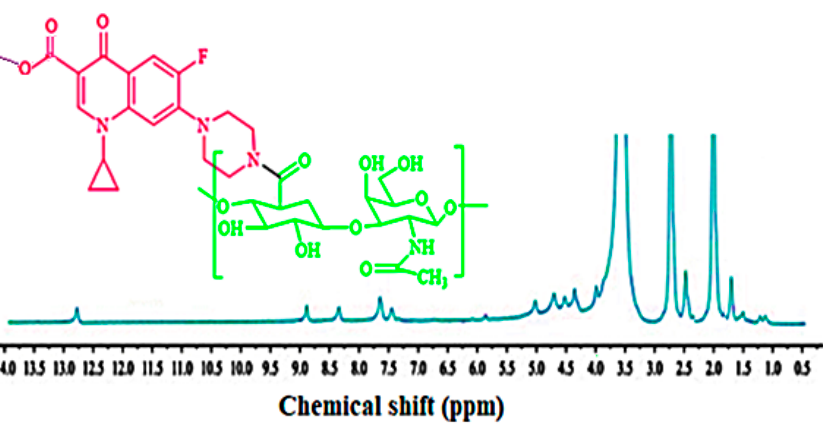
Figure 2. 1 H NMR spectra of HA-CIP conjugate in DMSO.